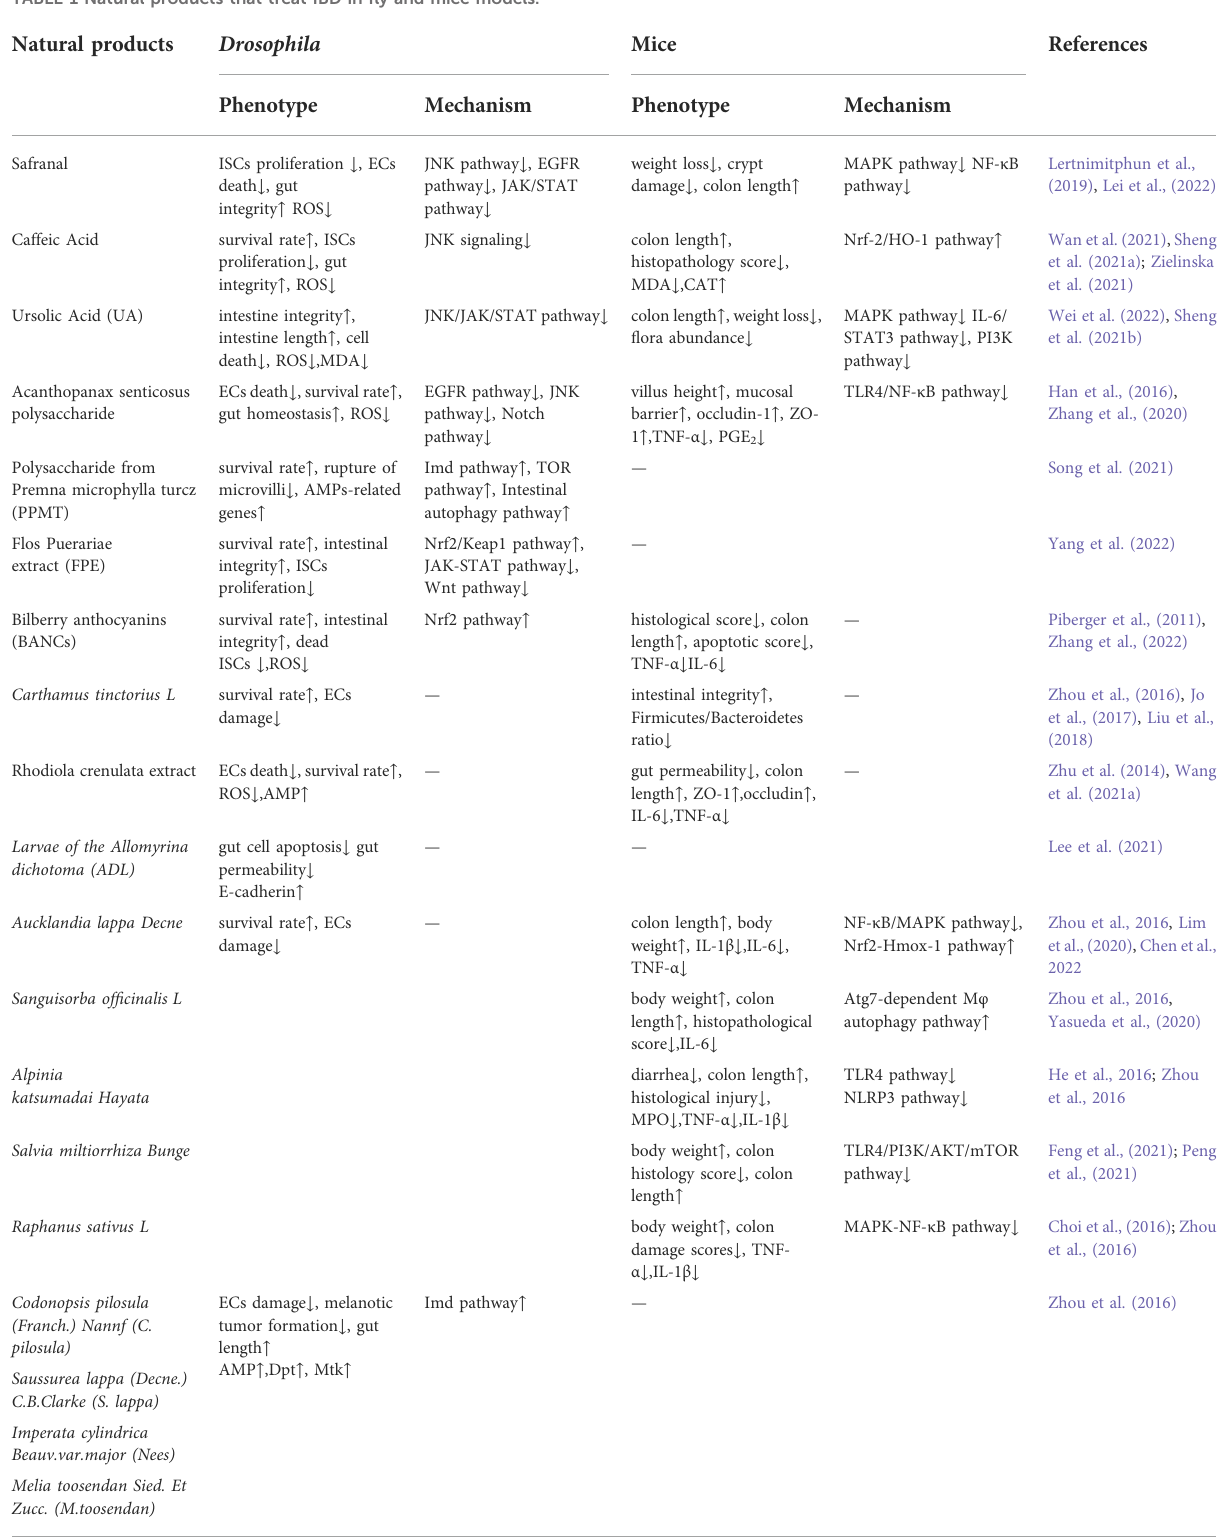
TABLE 1 Natural products that treat IBD in fl y and mice